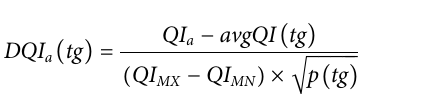
Frontiers in Chemistry |